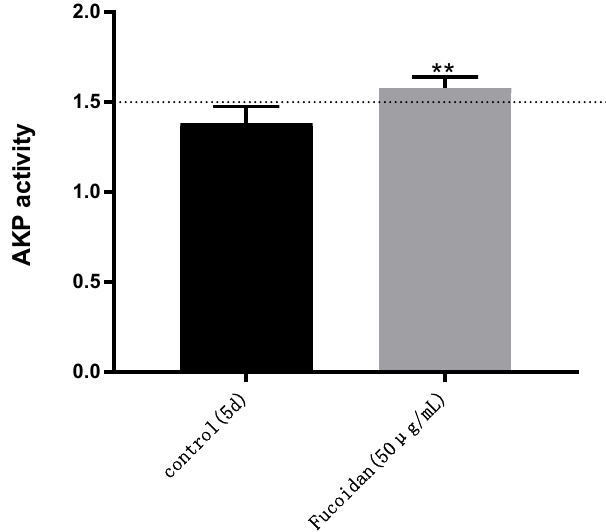
Figure 3. AKP activity: detection of AKP activity in different Caco-2 models on the fifth day (AP/BL). Control: DMEM containing 0.4 µ g/ mL puromycin. Fucoidan: DMEM containing 0.4 µ g/mL puromycin and 50 µ g/mL fucoidan. The two models were cultured at the same time and under the same conditions. Significance test: a t -test was conducted; ** p < 0.01.